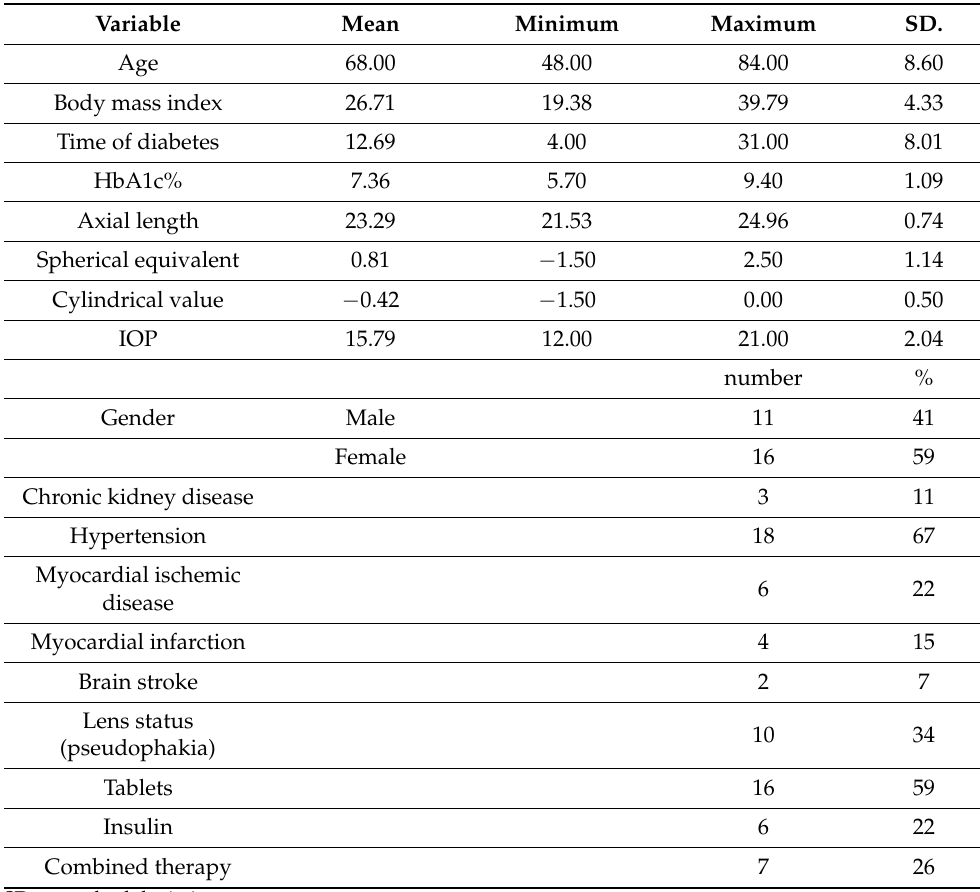
Table 1. Qualitative and quantitative variables of patients with diabetic macular edema (DME) qualified for the study described as unsatisfactory.